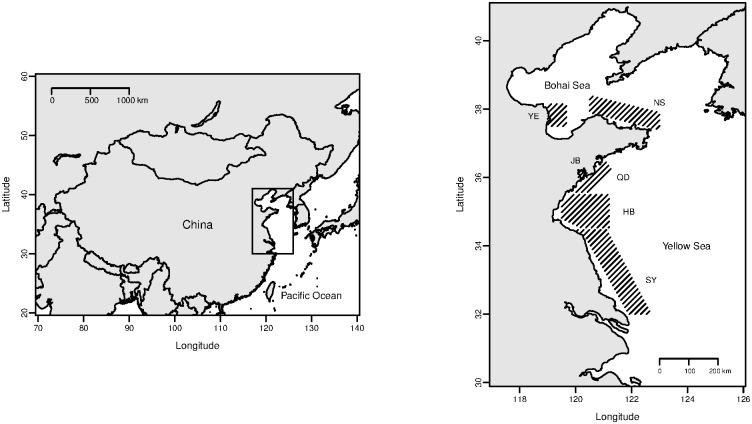
Survey map of Yellow Croaker along the north coast of China.The shades in the right plot showed the surveying area. Abbreviations of regions were detailed in Table 1.